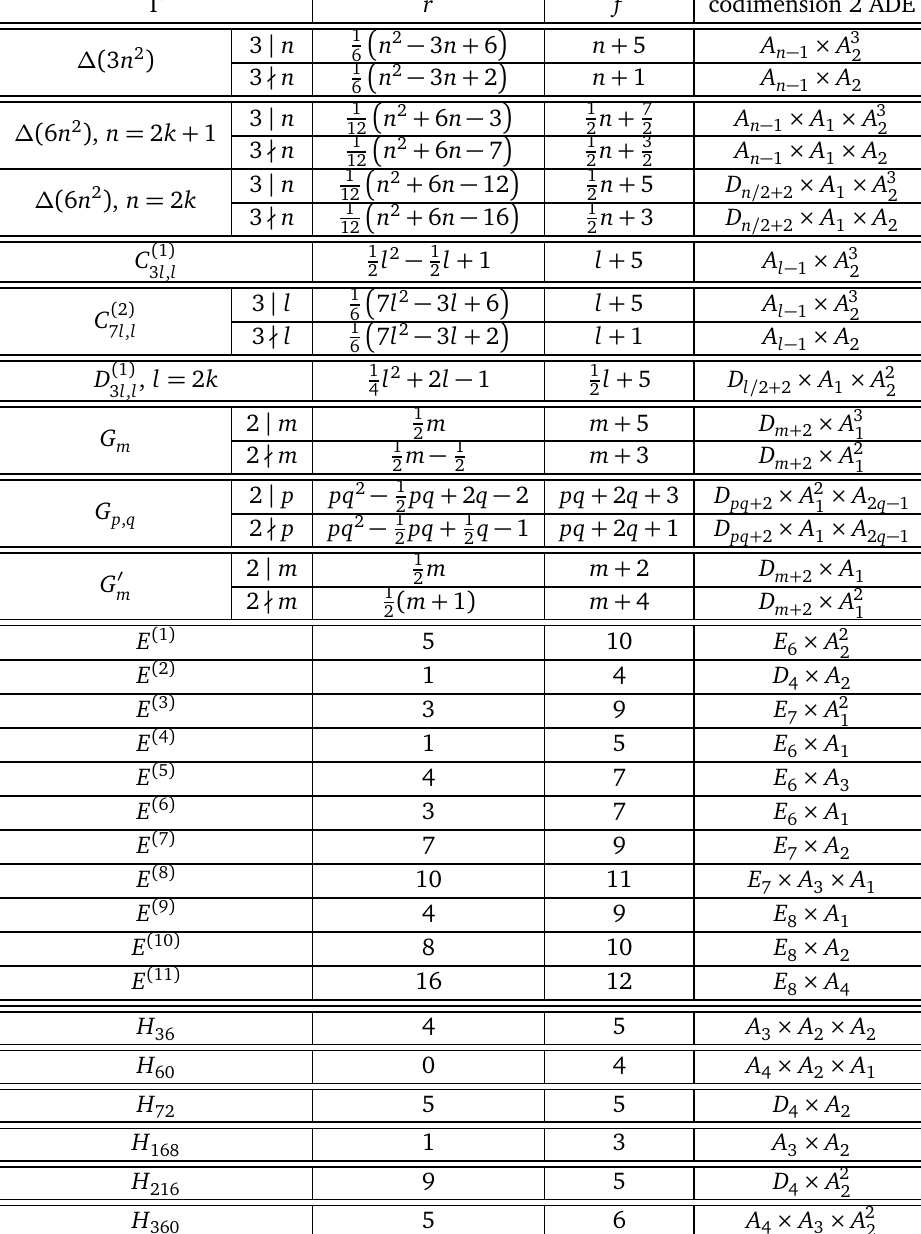
Table 2: Summary of the data associated to the non-abelian groups Γ covered in this